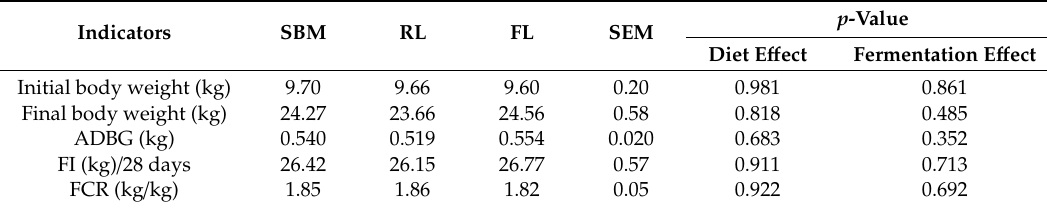
Table 3. Performance results of pigs.